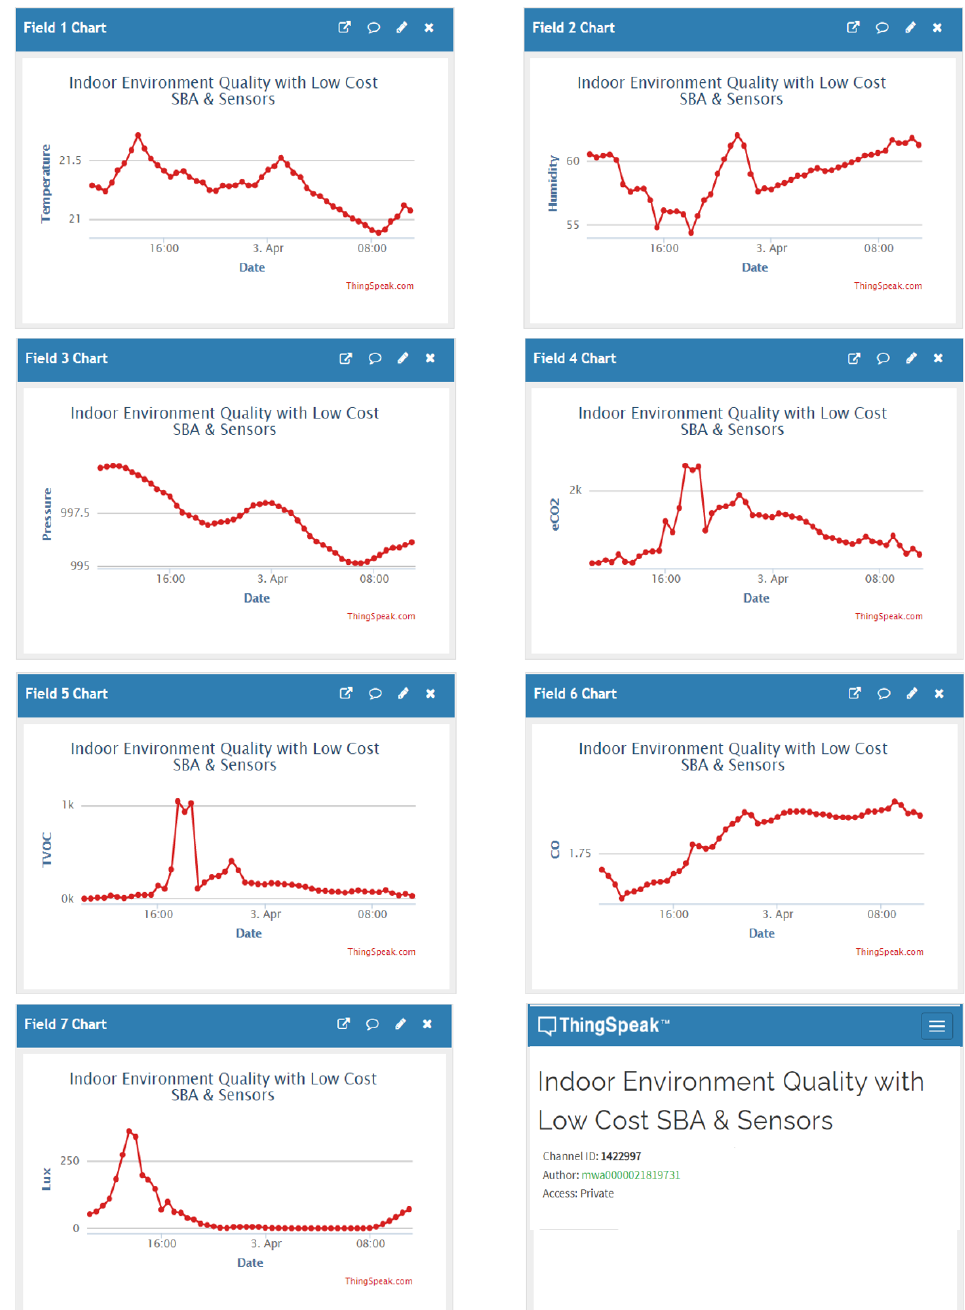
Figure 12. ThingSpeak channel catching the sensors data.